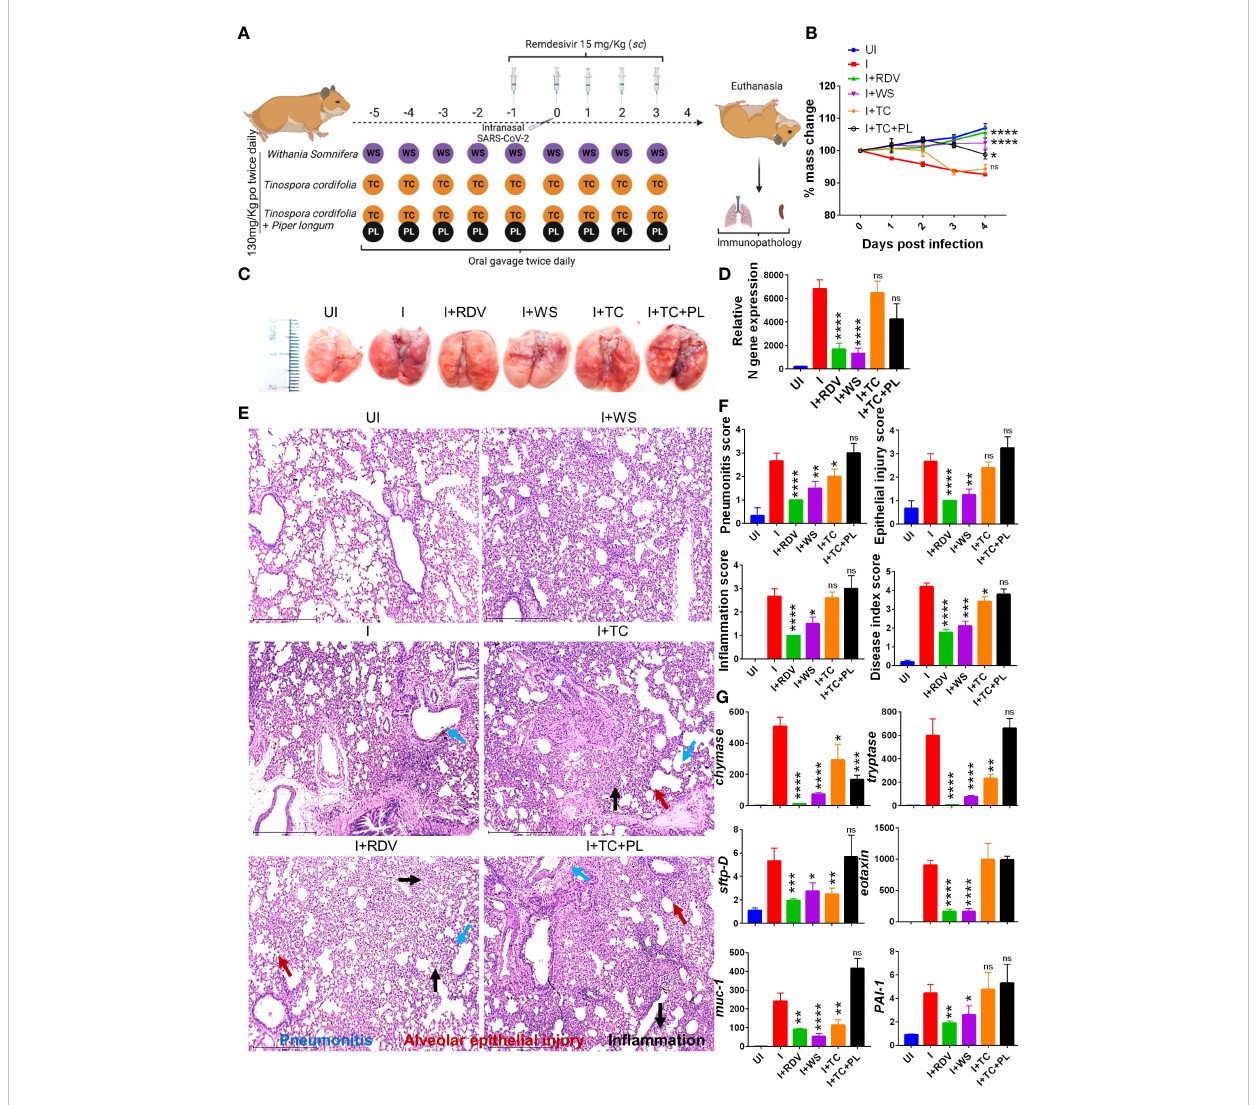
FIGURE 1 Prophylactic ef fi cacy of selected herbal extract on the SARS-CoV-2 infected hamsters. (A) Schematic representation of dosing regimen for prophylactic treatment of WS, TC or TC in combination with PL, positive control remdesivir (RDV), infection control (I) or uninfected hamster group. All the animals except the uninfected control was intranasally challenged with 10 5 pfu SARS-CoV-2 on day 0 and sacri fi ced on 4-day post infection (dpi). (B) Body mass of the animals were monitored post challenge and was plotted as %age change as compared to its day 0 body mass. (C) Representative images of harvested lungs post necropsy. (D) Relative viral load by N gene expression by qPCR shown as bar graph mean ± SEM. Histological analysis of left lung lower lobe was carried out post necropsy. The samples were fi xed in 10% neutral formalin solution, paraf fi n embedded, sectioned and hematoxylin (H) & eosin (E) stained. Stained sections were then imaged at 10X and assessed by trained pathologist for histological features. (E) Representative images of HE stained lungs showing pneumonitis (blue), bronchitis (red), epithelial injury (green) and in fl ammation (yellow). (F) Blinded pathological score for pneumonitis, bronchitis, lung injury, epithelial injury and in fl ammation as assessed by trained pathologist. (G) mRNA expression of key genes involved in cellular injury of lungs. For each experiment N=5. One way-Anova using